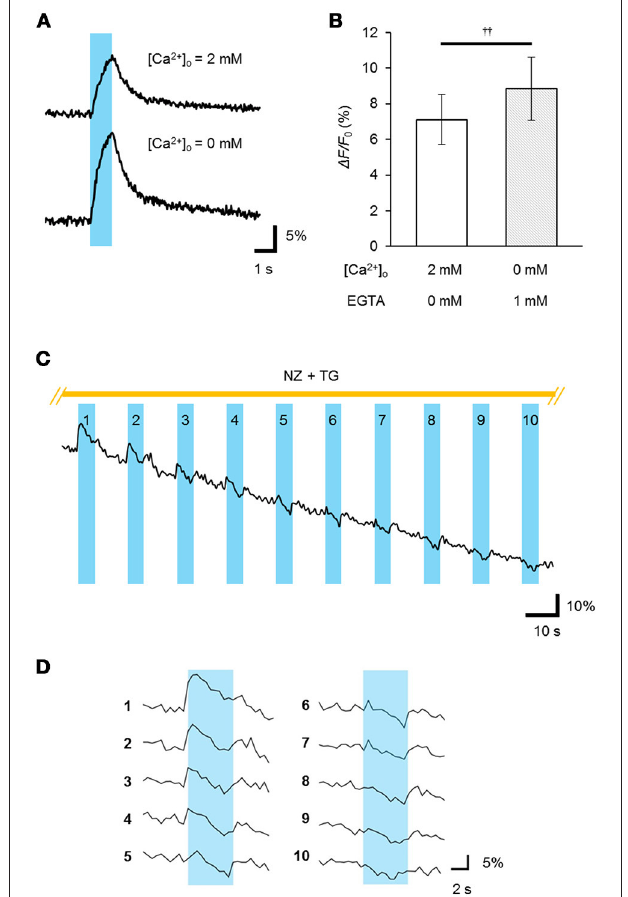
FIGURE 4 | Light-evoked release of Ca 2 + from the intracellular store. (A) The R-CaMP1.07 fluorescence increment ( 1 F / F 0 ) was recorded from a ChRGR ER -expressing C2C12 cell during optical stimulation (OS: a cyan stripe; 450 ± 10nm, 5ms pulse at 20Hz for 1s) applied in the presence (top) or absence (bottom) of [Ca 2 + ] o . (B) Summary of the peak 1 F / F 0 ( n = 7). †† p < 0.005, Wilcoxon signed rank test. (C) The light-dependent store depletion. The R-GECO1 signal ( 1 F / F 0 ) was sampled at 2Hz while the OS (cyan stripes; 451nm; duration, 20ms; 10Hz for 5s) was repetitively applied at every 15s to a ChRGR ER -expressing C2C12 cell in a [Ca 2 + ] o -free extracellular solution containing EGTA (5mM), nifedipine (NZ, 10 µ M) and thapsigargin (TG, 2 µ M). (D) The 1 F / F 0 signal was extracted from (C) for each cycle of OS. Each number indicate the order of the